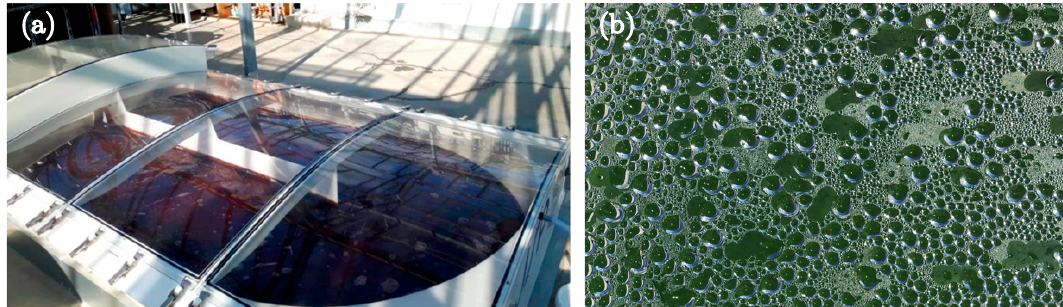
Figure 1. Photographs of ( a ) an outdoor photobioreactor at the R&D facility AlgoSolis (Saint-Nazaire, France) with a clear window cover and ( b ) condensed droplets formed on the back side of a photobioreactor (PBR) window during a summer